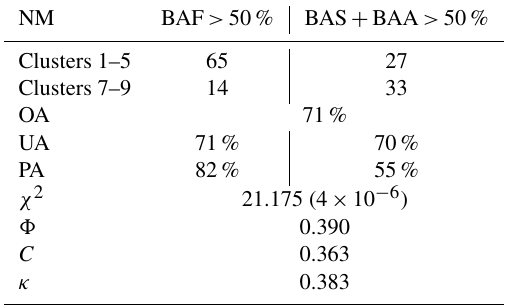
Table 3. Contingency tables and accuracy metrics to assess the role of vegetation burnt area (BA) assessed with DSRp90BA thresh- olds, for the municipalities used in cluster analysis. The contin- gency tables computed the number of municipalities (NM) for the following criteria: CLUST 1–5 (CLUST 7–9) and BAF >